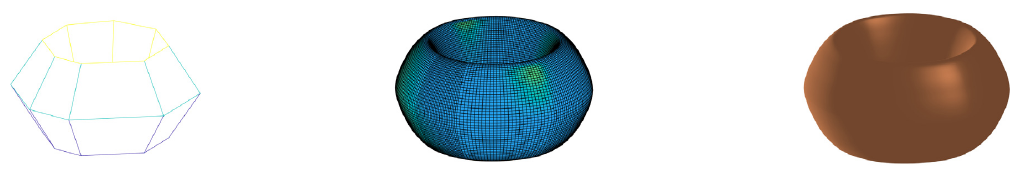
Figure 17. Subdivision surface of space with NULTISS. Left to right: initial mesh; mesh after three refinements; surface with lighting after three refinements.